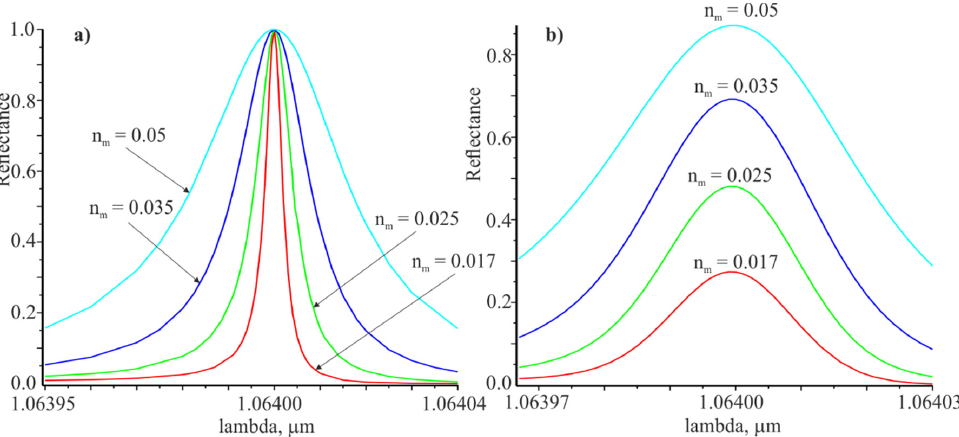
Figure 3. Spectral dependences of the reflection coefficient for the plane wave ( a ) and the Gaussian beam L = 20 at the resonance angle θ = π /9 ( b ). The red, green, blue and cyan curves correspond to the modulation coefficients of the refractive index n m : 0.017, 0.025, 0.035,